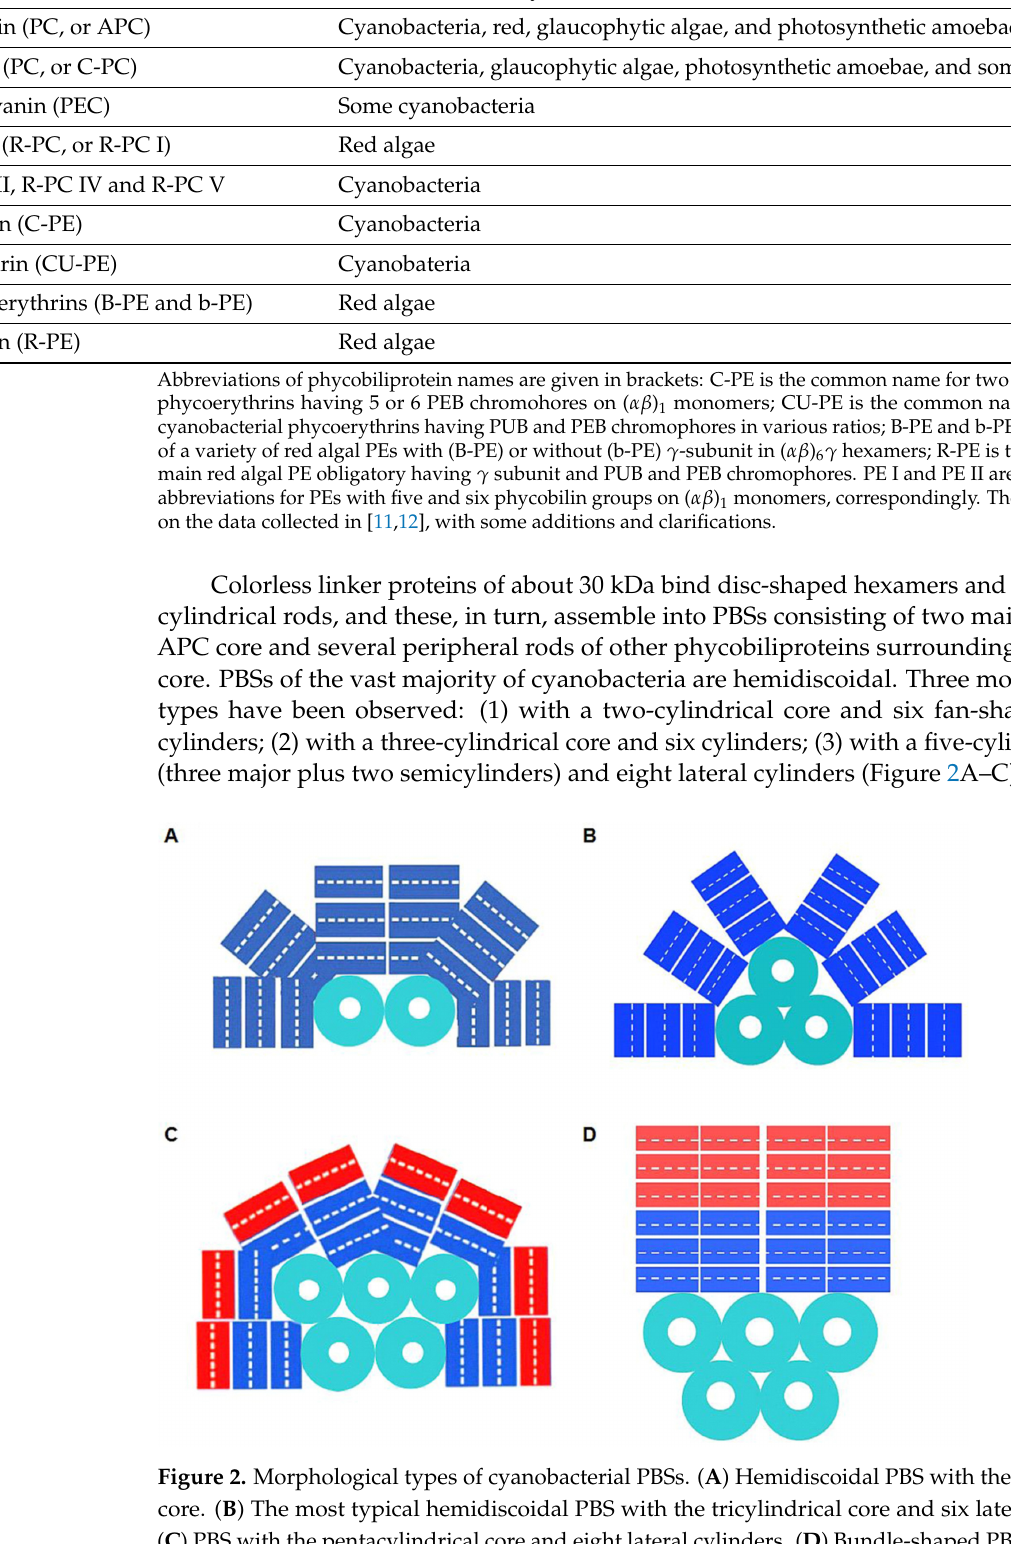
Table 1. Phycobiliproteins in various photosynthetic clades (except Cryptophyta). Phycobiliprotein